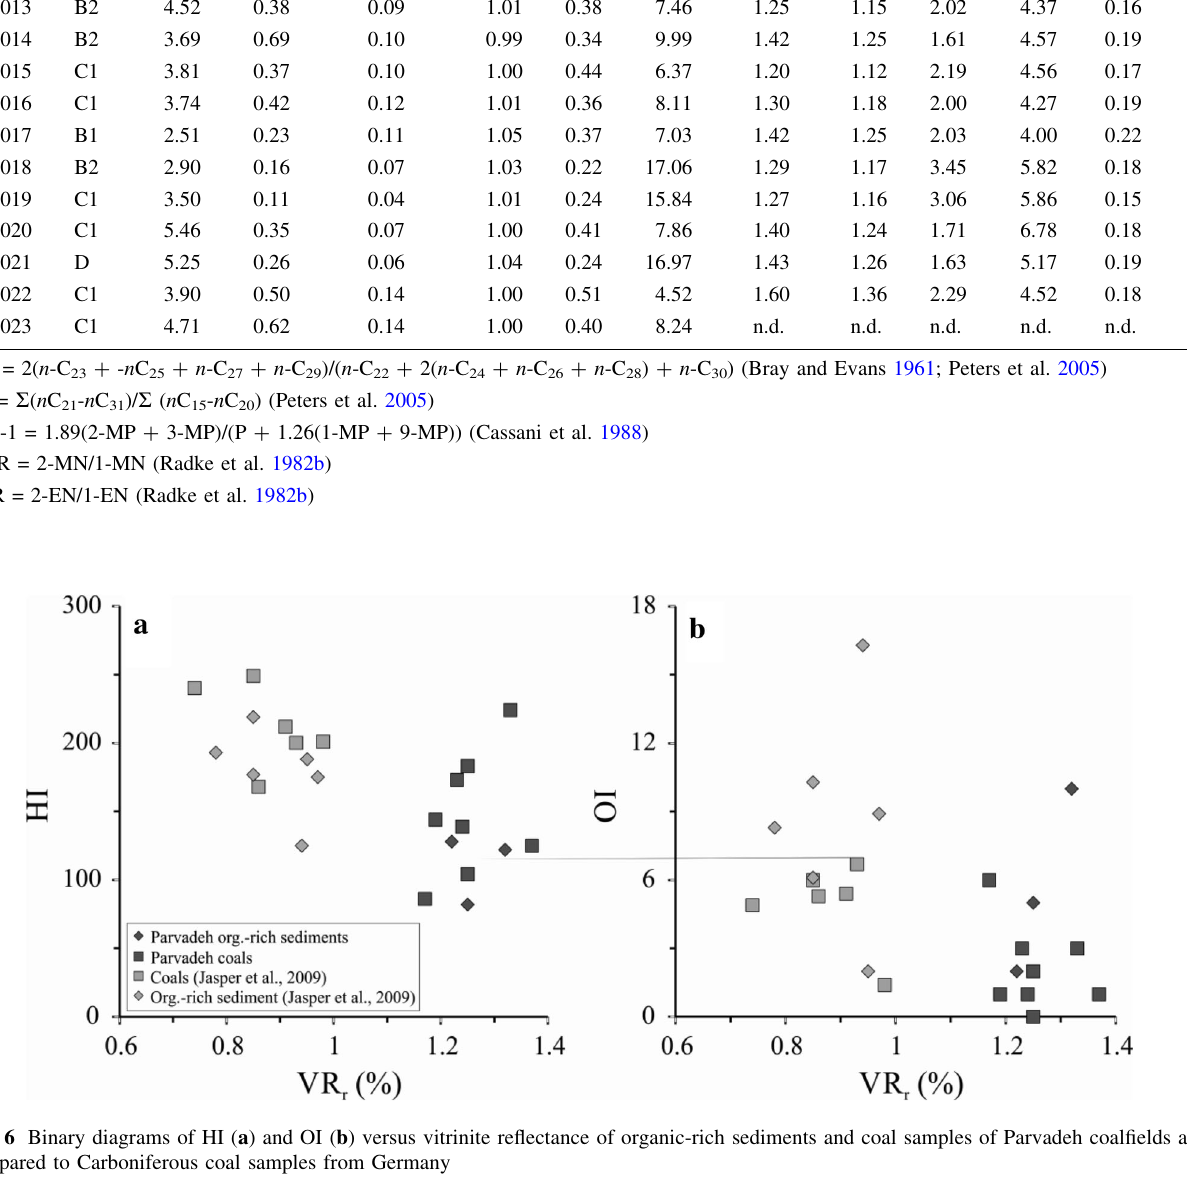
Table 5 GC–FID results of the aliphatic fraction and GC–MS results of the aromatic fraction of samples from the Parvadeh coalfield Sample Seam